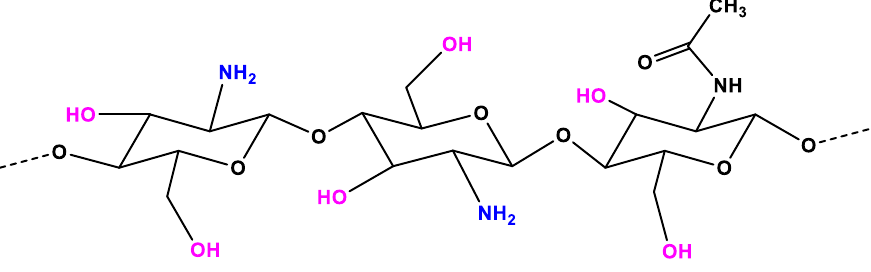
Figure 1. The chemical structure of chitosan (CS).